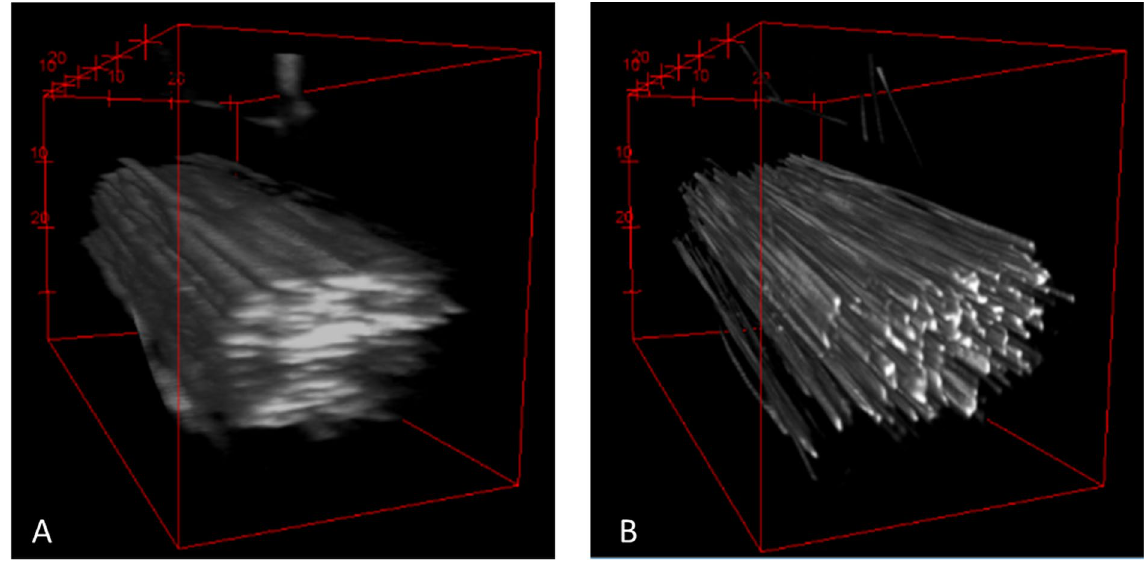
Figure 6. 3D rendering of rat-tail tendon. ( A ) Single view. ( B ) 8-view MVD. In the MVD single fibrils are clearly visible. (Images were created with Fiji 26